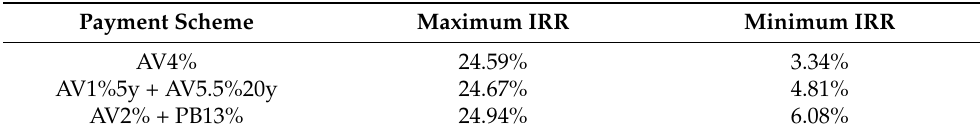
Figure 11. Distribution frequency histogram and cumulative probability distribution of IRR. (Note: the red bar indicates that the project is feasible). ( a ):AV4% ( b ): AV1%5y + AV5.5%20y ( c ): AV2% + PB13%. Table 12. Maximum value and minimum value of IRR in risk analysis.